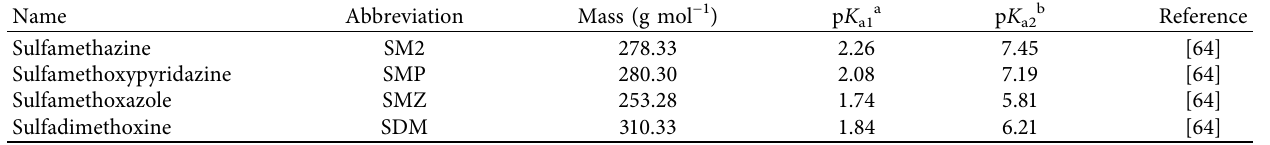
Table 1: Four SA target compounds and their basic